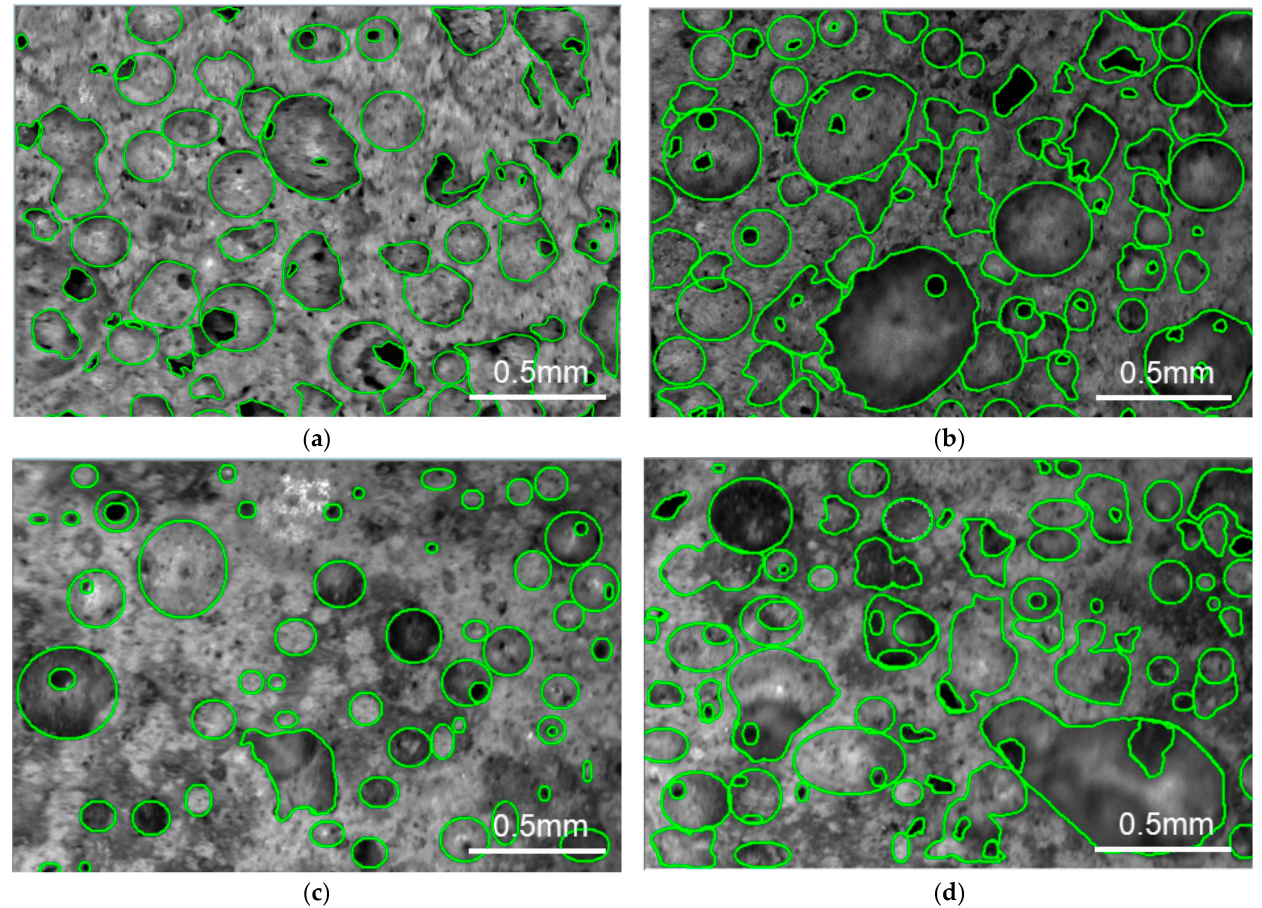
Figure 5. Photographs of HMNS-FA-phosphate-based porous geopolymers. ( a ) 0.2% H 2 O 2 , ( b ) 0.8% H 2 O 2 , ( c ) 0.02% Al, and ( d ) 0.08% Al.